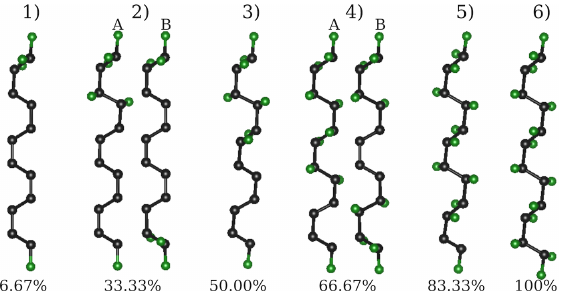
Figure 4. Top view of simulated fluorinated F-6ZGNRs with 6 different fluorination degrees. (A) denotes the asymmetric configuration, whereas (B) denotes the symmetric configuration. Table 1. Bandgaps and the average binding energy per F 2 for the most thermodynamically stable F-6ZGNR-based structures with each considered fluorination degree. All energy values are given in eV and they are obtained at the PBE